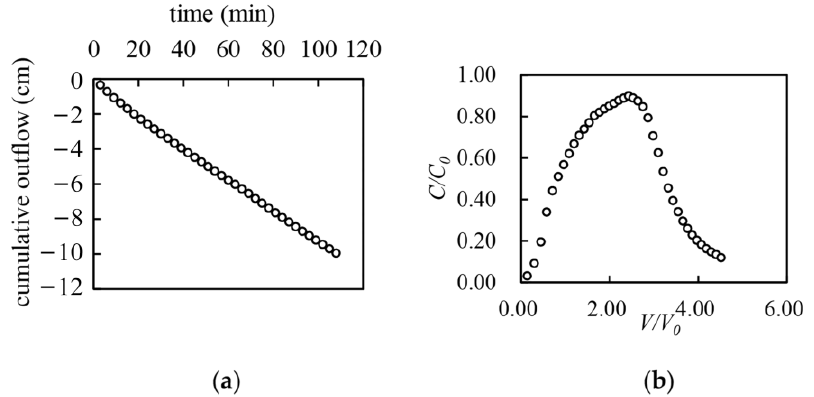
Figure 3. An example of measured data. ( a ) Cumulative outflow curve; ( b ) Solute breakthrough curve.